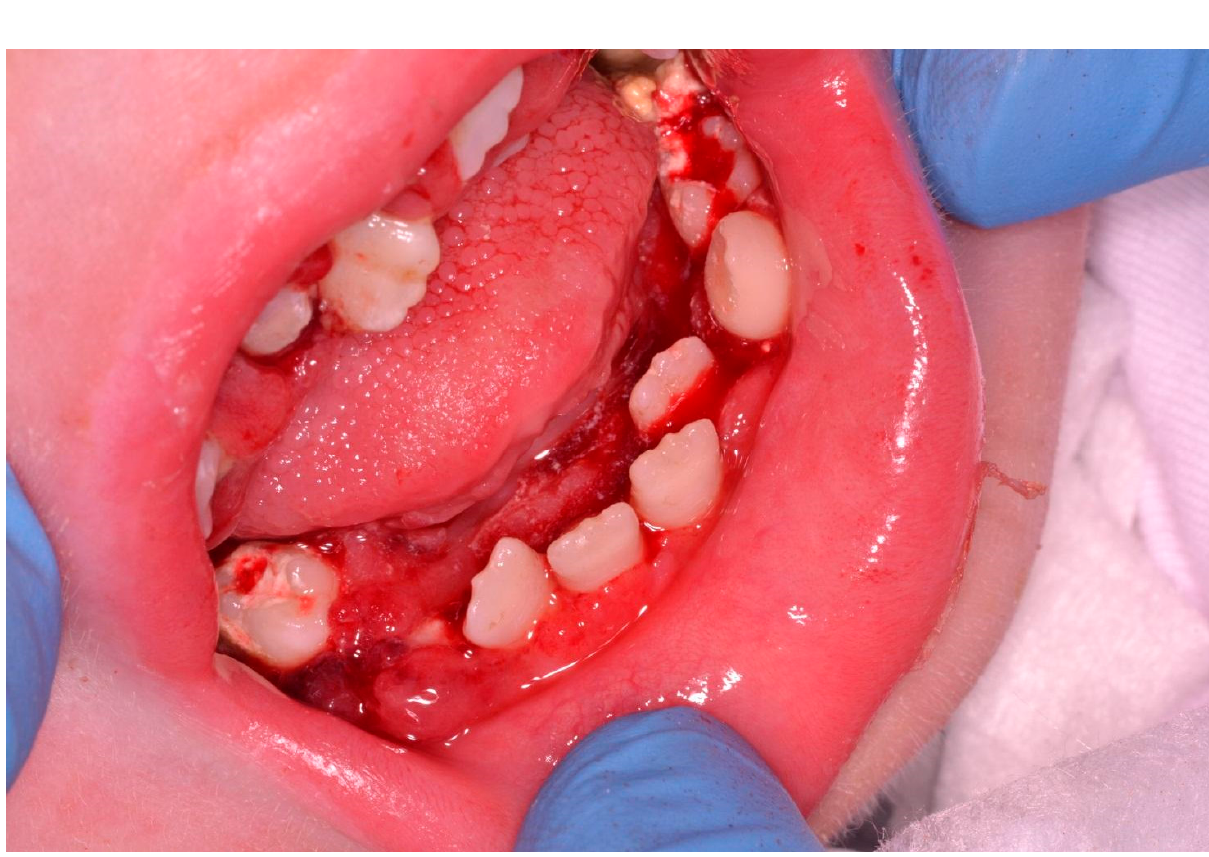
Figure 4. Patient reported in Figure 3 after dental treatment at the bedside. 3.7. Patient No. 7: 17-Year-Old Patient with Ventricular